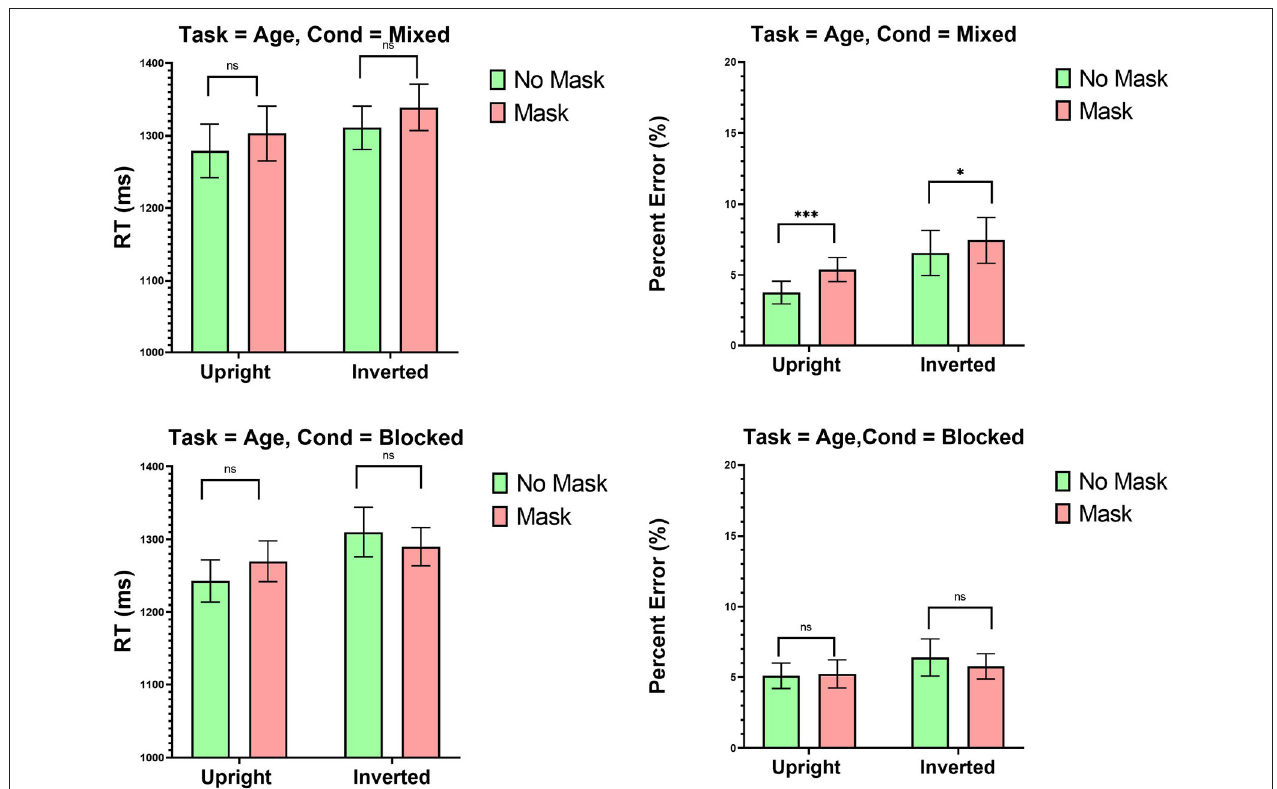
FIGURE 4 | Experiment 3: Mean RTs (ms) and percent error (%) as a function of mask (mask and no mask) and inversion (upright and inverted). Top panel: Mixed condition, bottom panel blocked condition. *** p < 0.001, ** p < 0.01, and * p < 0.05. Error Bars are Standard Errors of the Means.